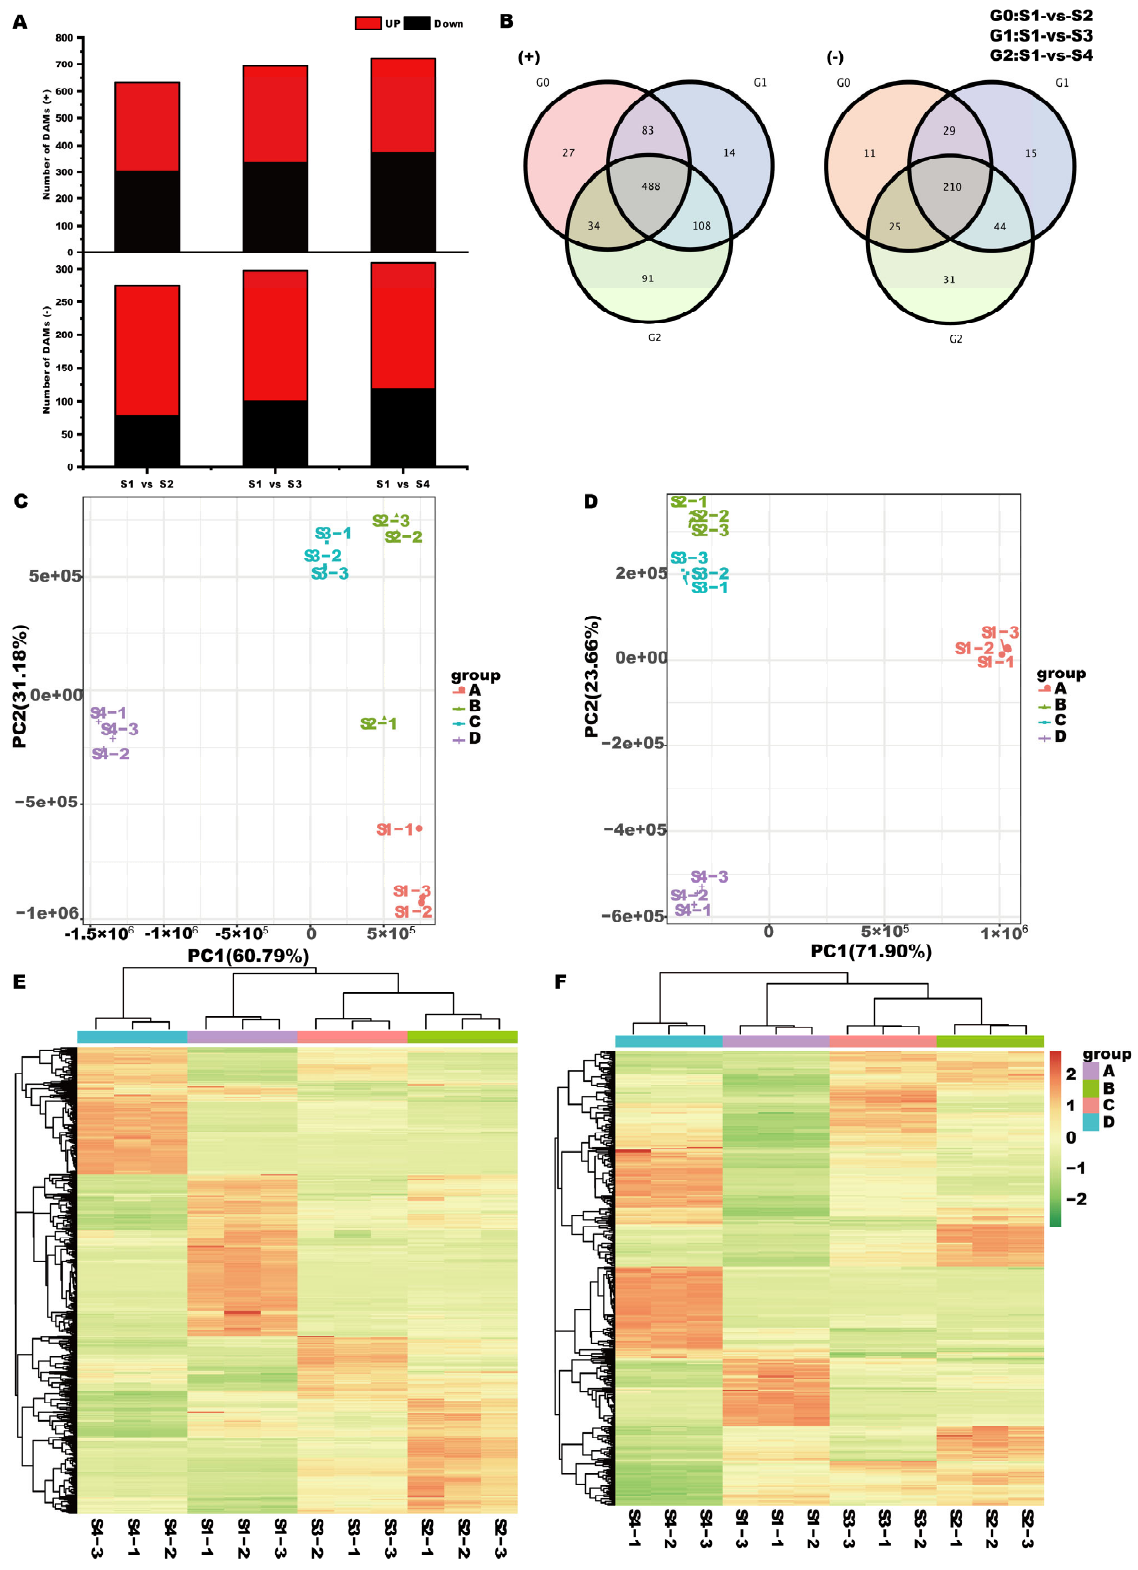
Figure 5. Metabolome analysis of Chinese fir seeds during germination. ( A ) DAMs of seeds. ( B ) A Venn diagram in positive ion mode and negative ion mode. ( C ) PCA of samples in posi- tive ion mode. ( D ) PCA of samples in negative ion mode. ( E ) A heatmap of DAMs in positive ion mode. ( F ) A heatmap of DAMs in negative ion